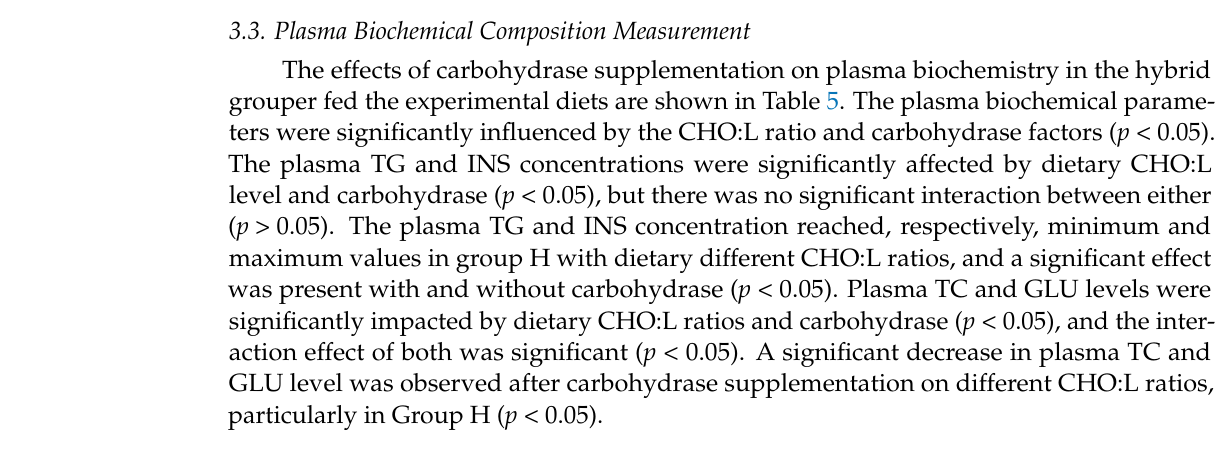
Table 5. Effects of carbohydrase supplementation on plasma biochemistry in hybrid grouper fed different CHO:L ratios